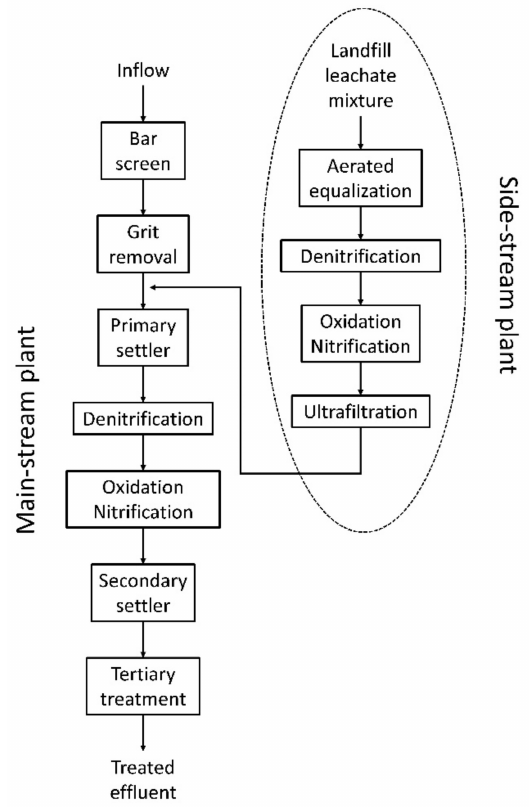
Figure 1. Simplified flow diagram of the Calice wastewater treatment plant